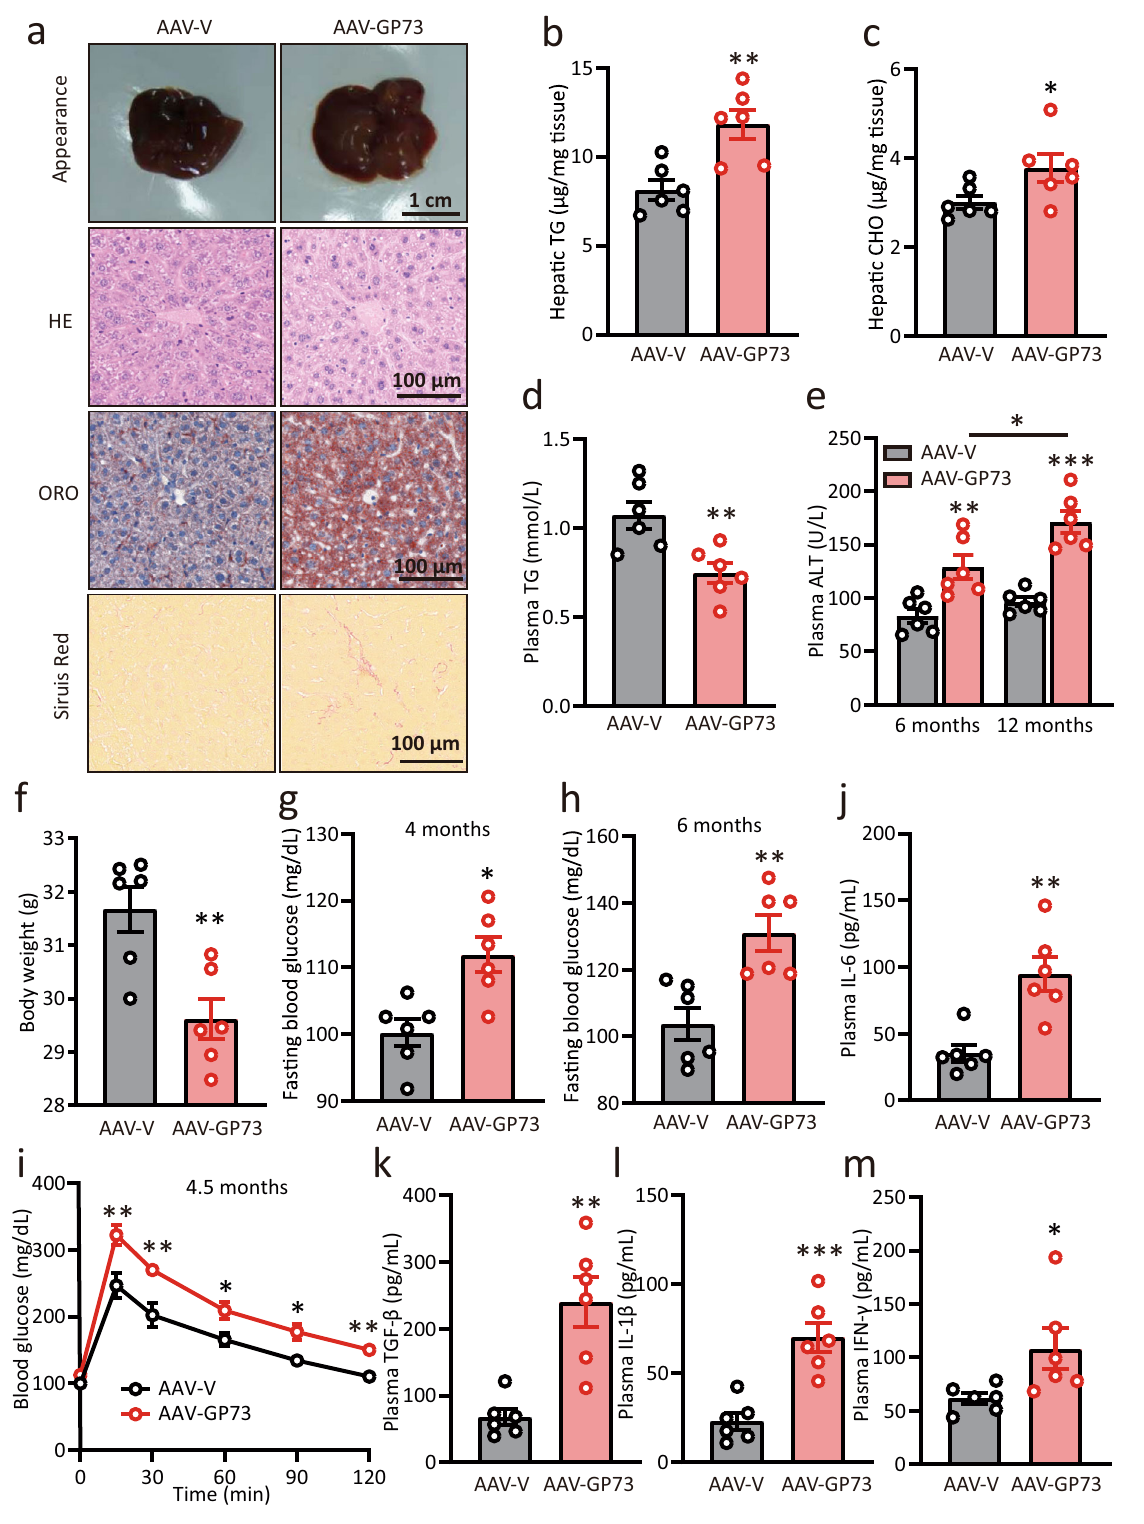
control mice (Fig. 4c and Supplementary Fig. 5). The FA bio- synthesis enzyme Fasn and the acetyl-CoA (substrate for lipid synthesis)-producing enzyme ACLY ATP-citrate lyase (Acly) were downregulated, whereas the cholesterol biosynthesis enzyme 3-hydroxy-3-methylglutaryl (HMG)-CoA synthase (Hmgcs) 2